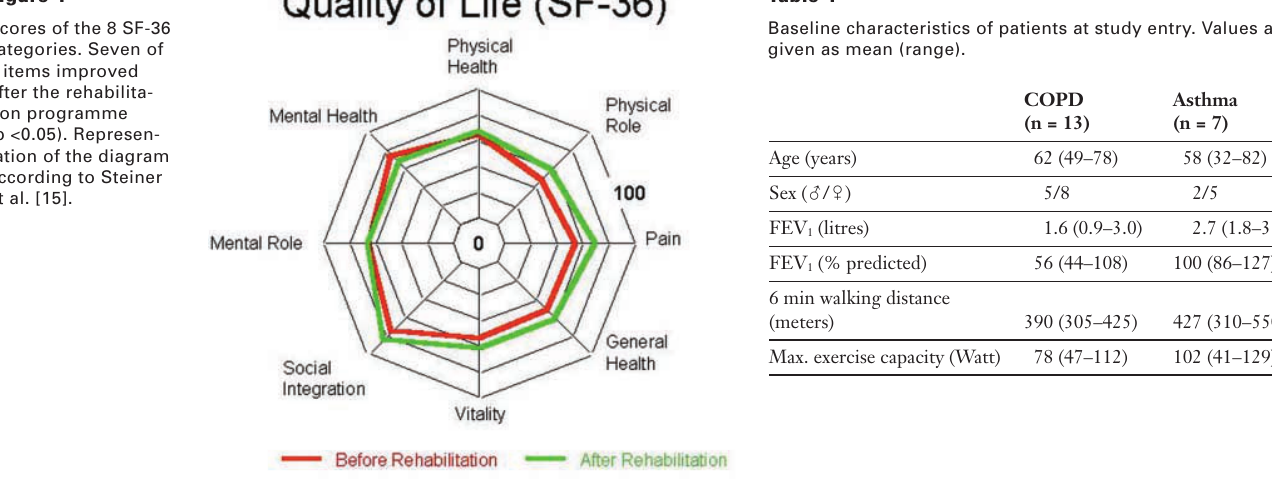
Percent improvement in cardiopulmonary exercise testing parameters. Values are mean % change ± SEM. Six minute walking distance (n = 10), maximum oxygen uptake (n = 20) and exercise tolerance (n = 20) improved significantly (p <0.01, p <0.05 and p <0.001, respectively), whereas the anaerobic threshold remained unchanged (p>0.80).